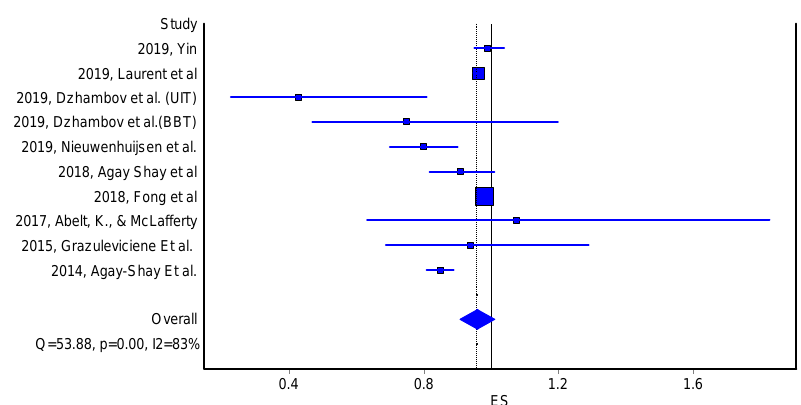
Figure 3. Forest plot on the effect of residential greenness (NDVI) on low birth weight (odds ratio, quality effects model). Note: ES—effect size; Q and I2—heterogeneity statistics. Horizontal lines, square and diamond symbols are indicating confidence intervals, effect estimates and overall effect, respectively.